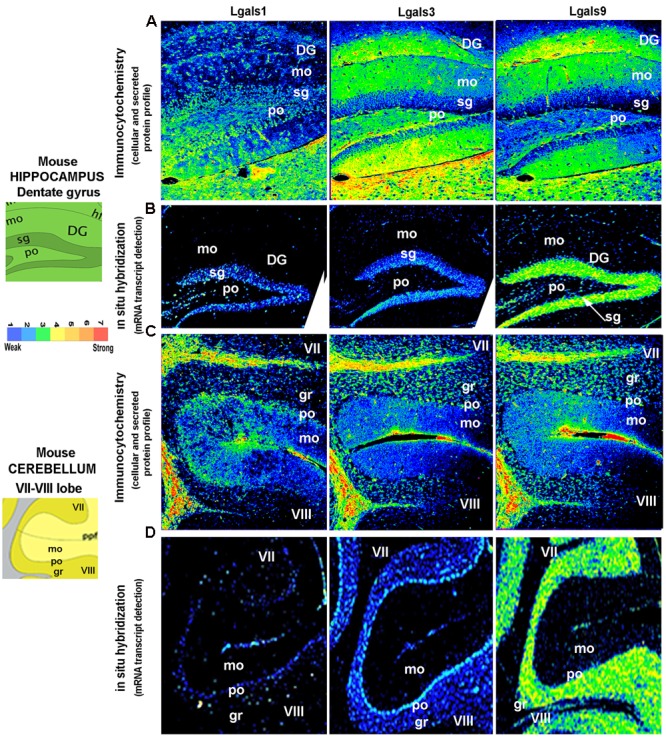
Comparison and validation of galectins mRNA expression with protein profiling in mouse Hippocampus and Cerebellum. (B,D) ABA based mRNA expression profile of 3 major galectins in the Dentate Gyrus region of the hippocampus and VII–VIII lobe of the cerebellum is compared with immunohistochemistry based protein expression in the respective regions as shown in (A,C). DG, dentate gyrus; mo, molecular layer; sg, sub-granular layer (a zone of adult neurogenesis); po, polymorph layer in DG and Purkinje cell layer in cerebellum; gr, granule cell layer; VII/VIII, 7th and 8th lobe of cerebellum with prepyramidal fissure(ppf). Pseudo-color calibration bar is included to represent the intensity of expression. Note a good regional corroboration between mRNA and protein expression except that the protein expression is more widespread due to the secretory nature. The sub-granular zone of the DG that expresses the transcript is essentially low in intracellular protein pool, probably due to secretion. The protein is also detected in the extracellular space and on surface of cells is suggestive of autocrine-paracrine effects.